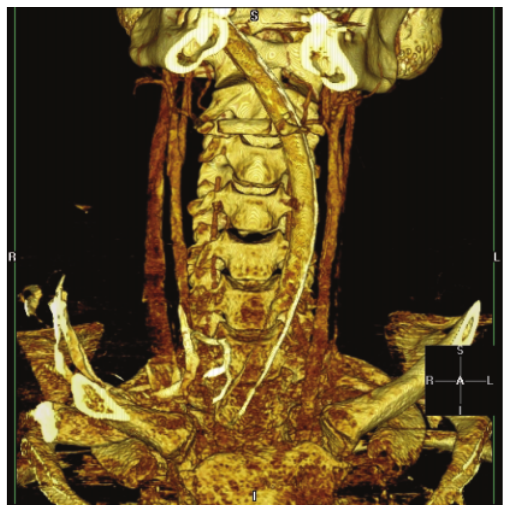
Figure 2: Three-dimensional CT scan of